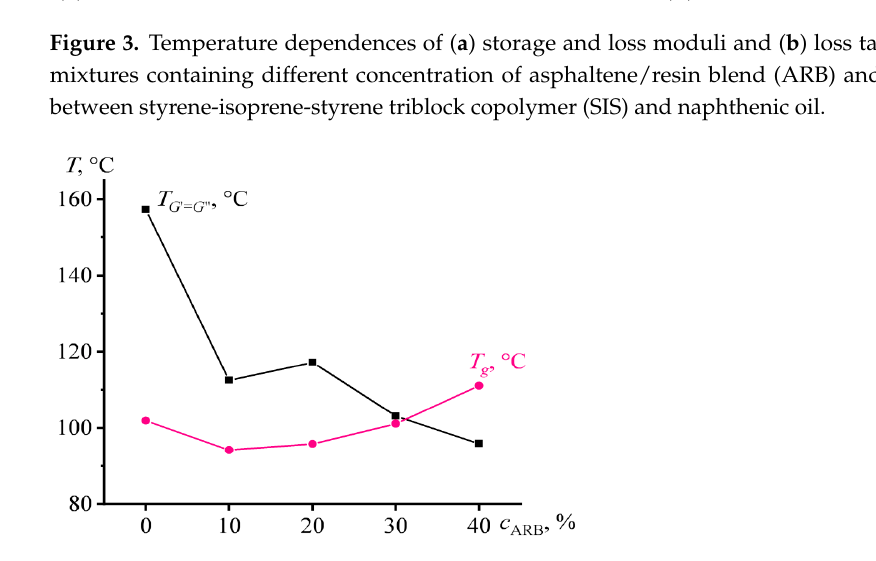
Figure 4. Concentration dependences of glass transition temperature and liquid–solid transition point for mixtures with different concentrations of asphaltene/resin blend (ARB) and an equal ratio between styrene ‐ isoprene ‐ styrene triblock copolymer and naphthenic oil.